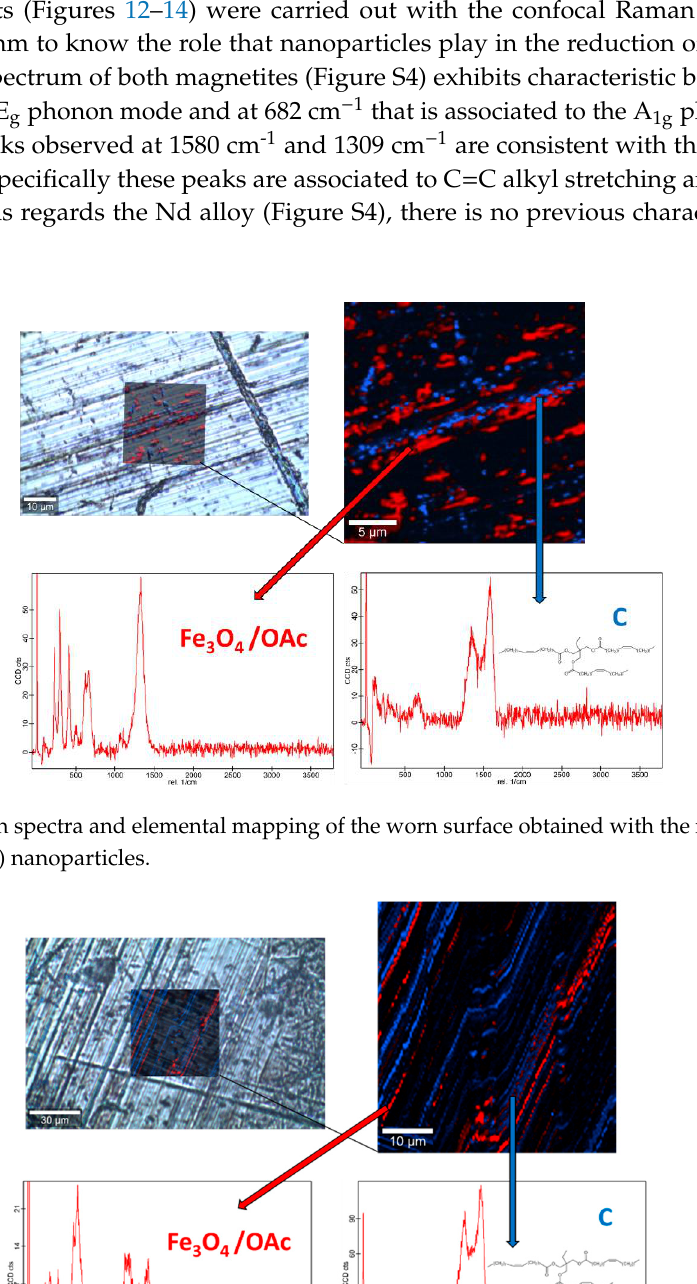
Figure 13. Raman spectra and elemental mapping of the worn surface obtained with the nanolubricant of Fe 3 O 4 (10 nm) nanoparticles.